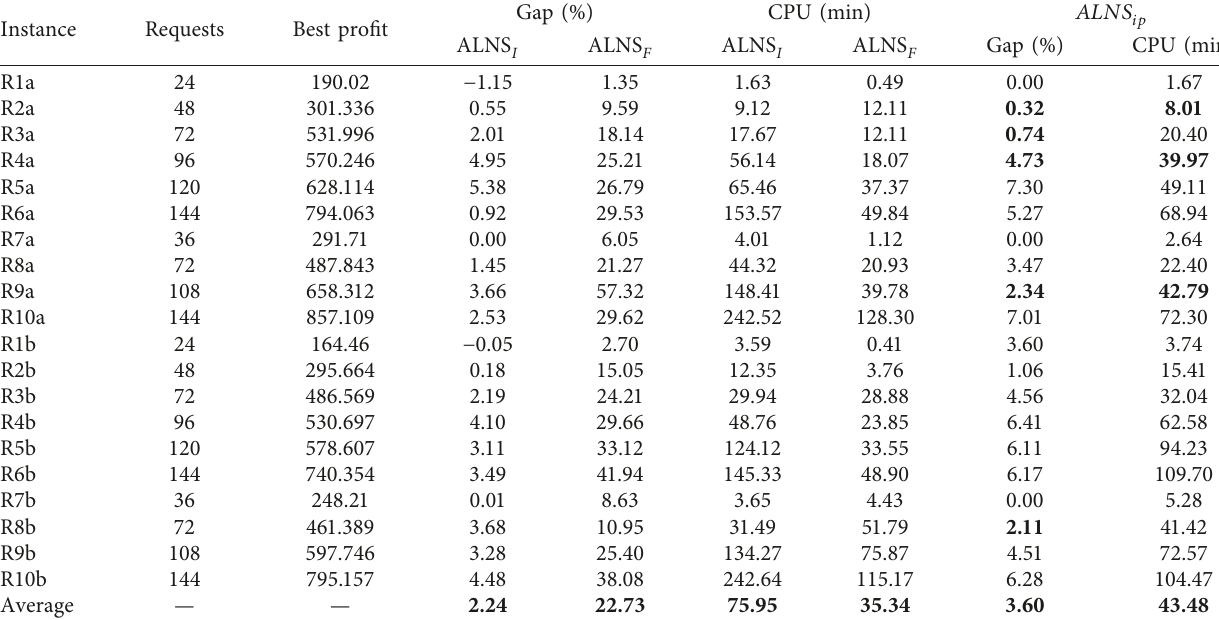
Table 8: Compared results of ALNS ip on the benchmark DARP instances.